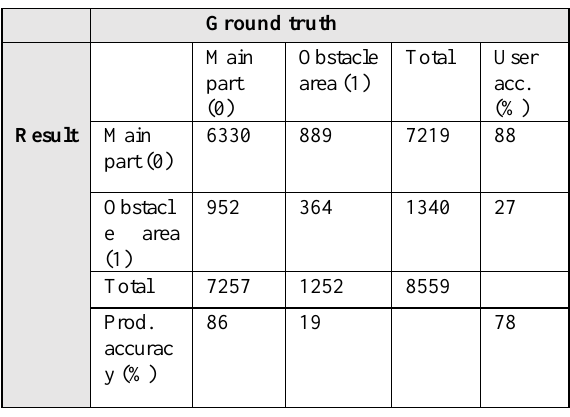
Table 2 . Contingency matrix for a sample building, using manual ortho-photo